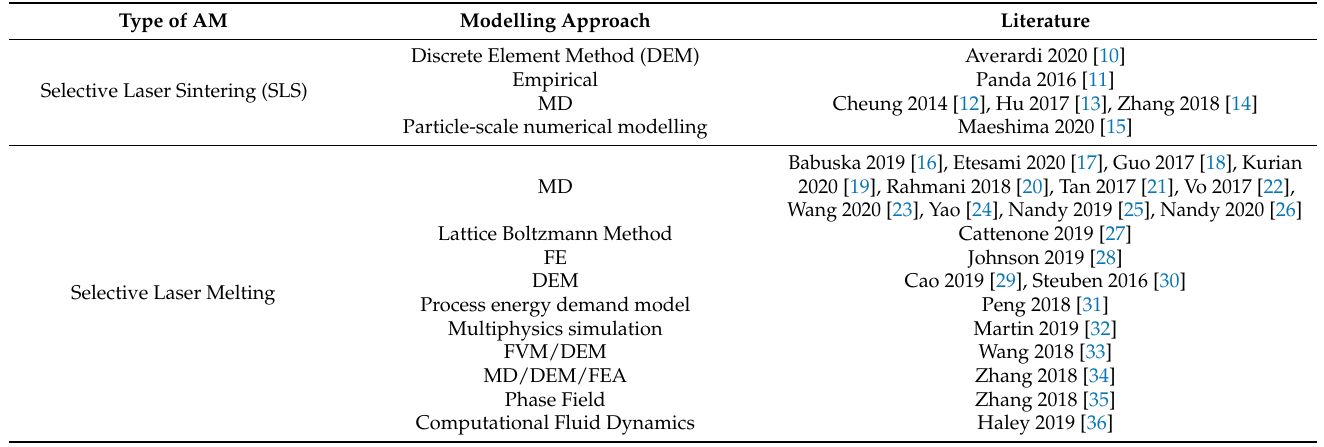
Table 1. Categorization of literature according to type of Additive Manufacturing and Modell- ing